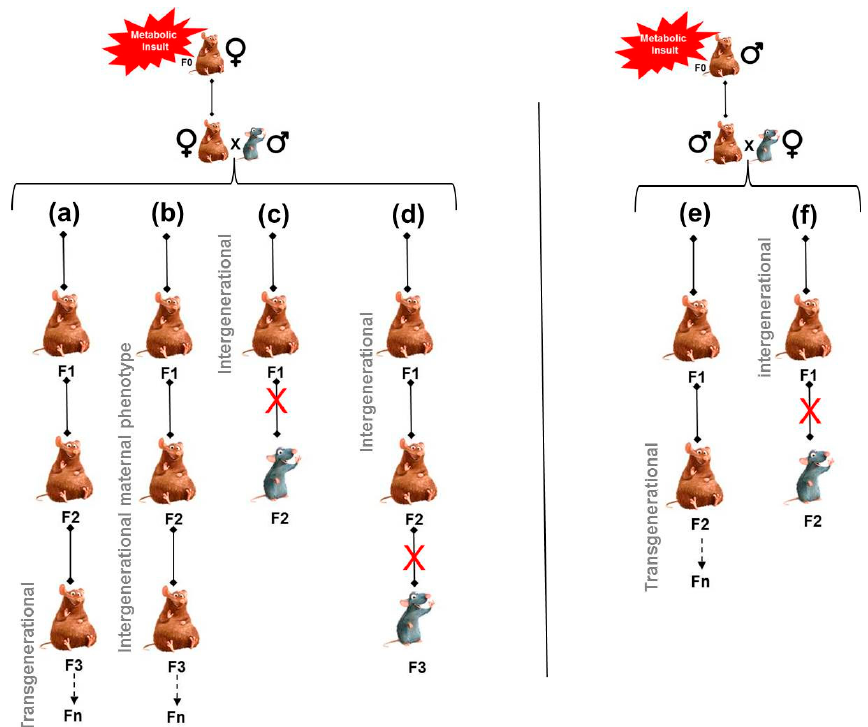
Figure 2. Non-genetic transmission of parental programming effects. Left panel: Maternal exposure to a metabolic insult (such as an unbalanced diet, obesity, diabetes) (brown rodent) influences both her developing fetus in utero (F1) as well as the developing germ cells in the fetus which later give rise to F2, both of which are present at the time of environmental exposure. When phenotypes do not persist after F1 or F2, such a programming effect is referred to as intergenerational inheritance (c,d). However, the cells which form the F3 generation are not present at the time of environmental exposure. If they still carry phenotypes in the F3 generation, they do so by transgenerational inheritance (a). This transgenerational inheritance (non-genetic) appears to be mediated through the transmission of epigenetic information through the germline [6,80,81]. Another mechanism for the transmission of programming effects is that programmed changes in the F1 mother (maternal physiology and behavior) influence the F2 offspring development, and so on. In this case, the metabolic insult is the altered maternal phenotype and the altered phenotype is established de novo in each new generation (b). Such a programming effect is referred to as maternal phenotype intergenerational inheritance (b). Right panel: For paternal exposure to a metabolic insult (brown rodent), only the sperm cells which form the F1 generation are present and directly exposed to the insult. When phenotypes do not persist after F1, the programming effect is referred to as intergenerational inheritance (f). When phenotypes persist into F2 and beyond, it is referred to as transgenerational inheritance (e). This transgenerational inheritance (non-genetic) appears to be mediated through the transmission of epigenetic information through the paternal sperm cells [6,80,81].